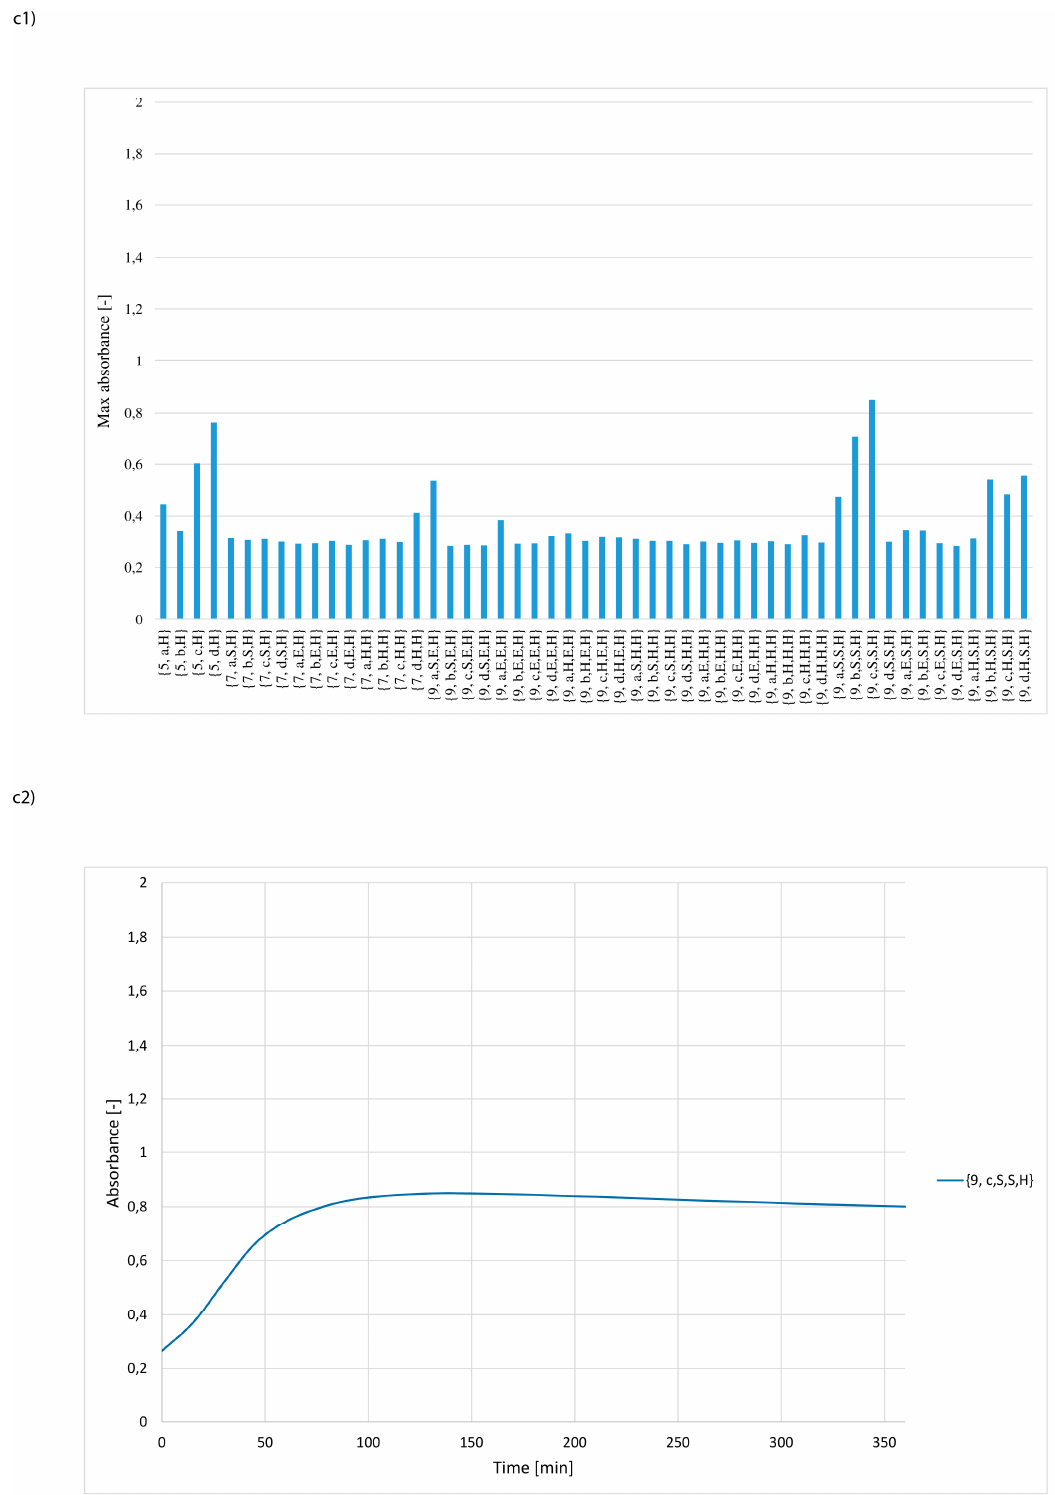
Figure 4. Selection of the most active synzymes (maximum absorbance assay) (upper panel 1) and measurement of Z-Leu-NA hydrolysis in a solution at pH = 8.5 using the selected the most active synzymes (lower panel 2): ( a ) sub-library of synzymes with serine reside at C-terminal positions, ( b ) sub-library of synzymes with glutamic acid reside at C-terminal positions, ( c ) sub-library of synzymes with histidine reside at C-terminal positions.